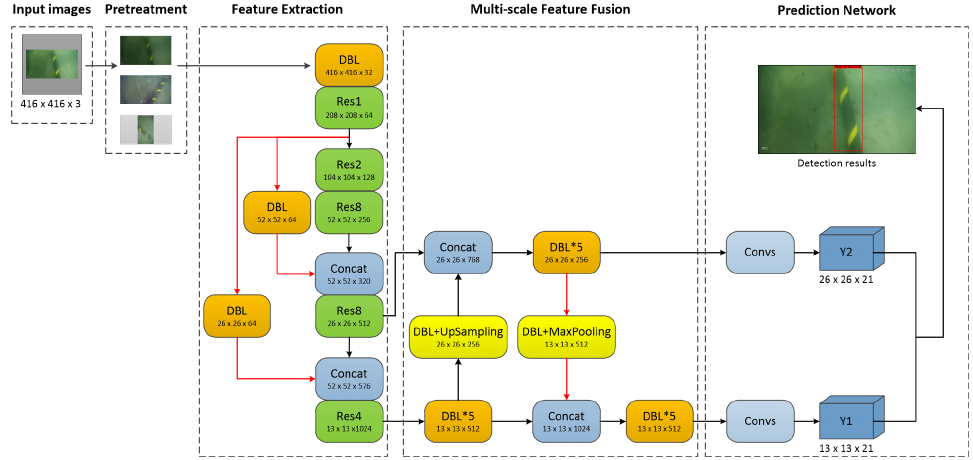
Figure 5. Proposed YOLO-SC network structure.